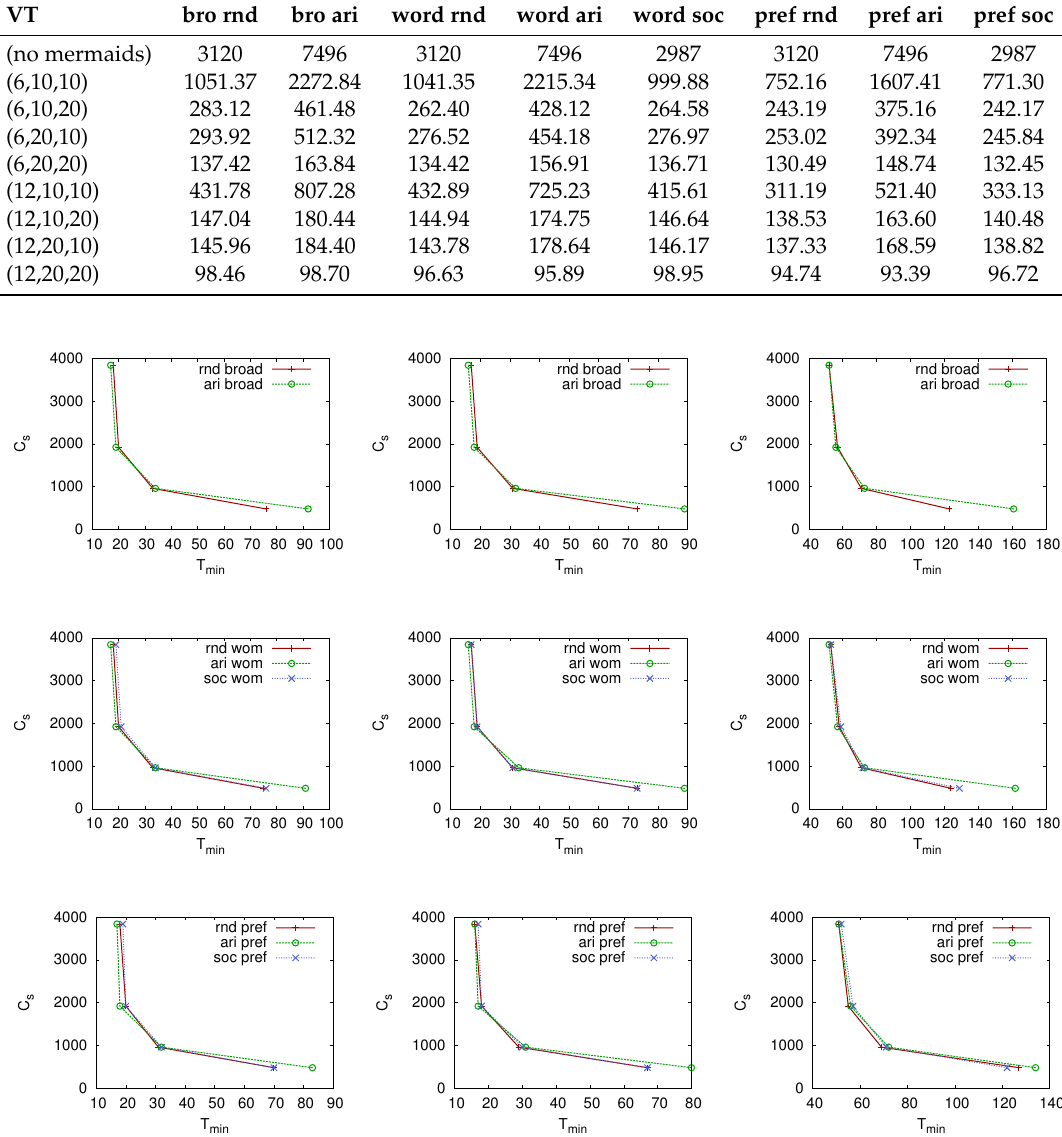
Table 6. Summary of the average T min in all configurations ( m , a , d ) of accelerated analysis with and without mermaids. Mermaid’s dynamics are broadcast (bro), word of mouth (word) and preferential (pref), combined with users’ dynamics random (rnd), aristocratic (ari) and social (soc). VirtualTourist online social network.